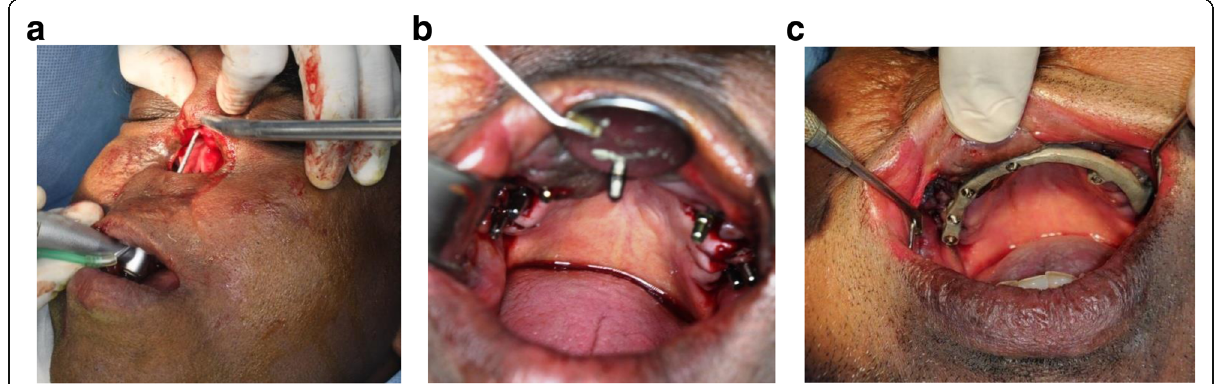
Fig. 5 a Glabella implant osteotomy. b Implant placement procedure. c Metal